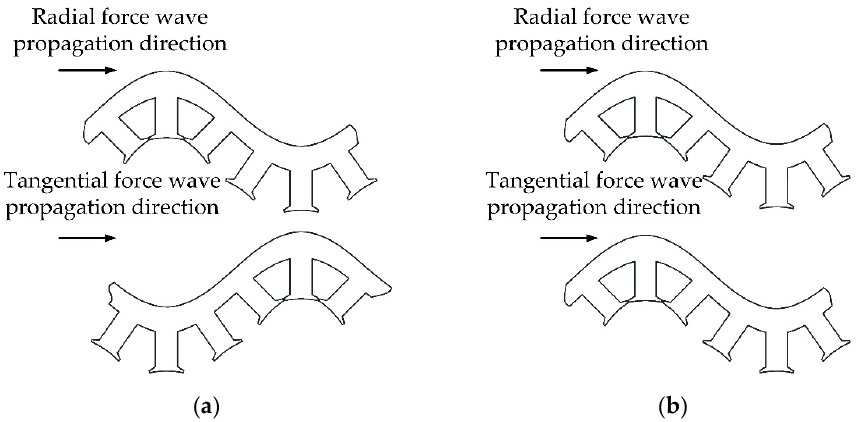
Figure 3. Stator deformation outspread diagram induced by the electromagnetic force wave. ( a ) Weakening effect; ( b ) enhancement effect. ening effect; ( b ) enhancement effect.